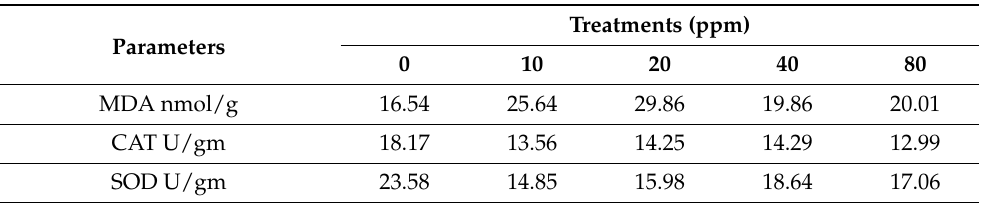
Table 10. Serum antioxidant biomarkers of the Nile tilapia , O. niloticus exposed to different concentra- tions of biosynthesized Hi